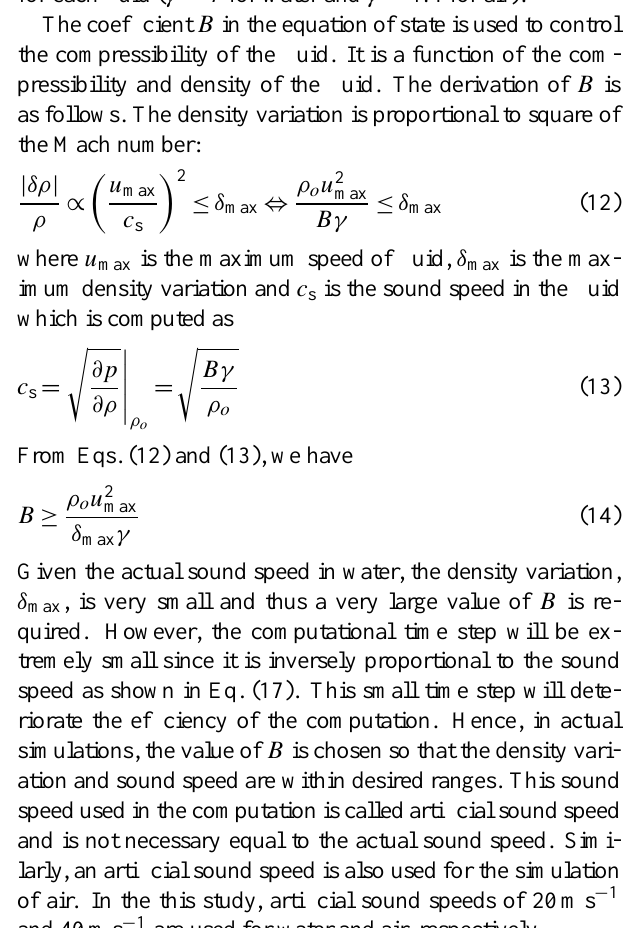
our preliminary simulations, adequate results are obtained at high resolution simulations if the 5th order polynomial func- tion is used. The function and its derivative are shown in Fig.